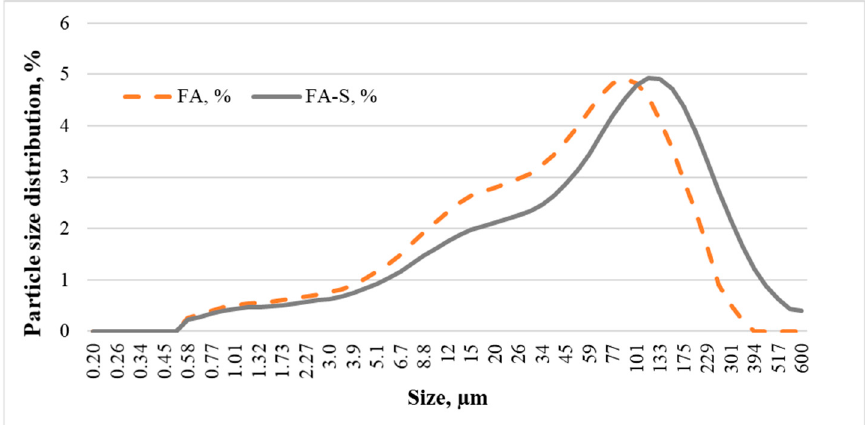
Figure 1. The fly ash and fly ash–slag particle size distributions.